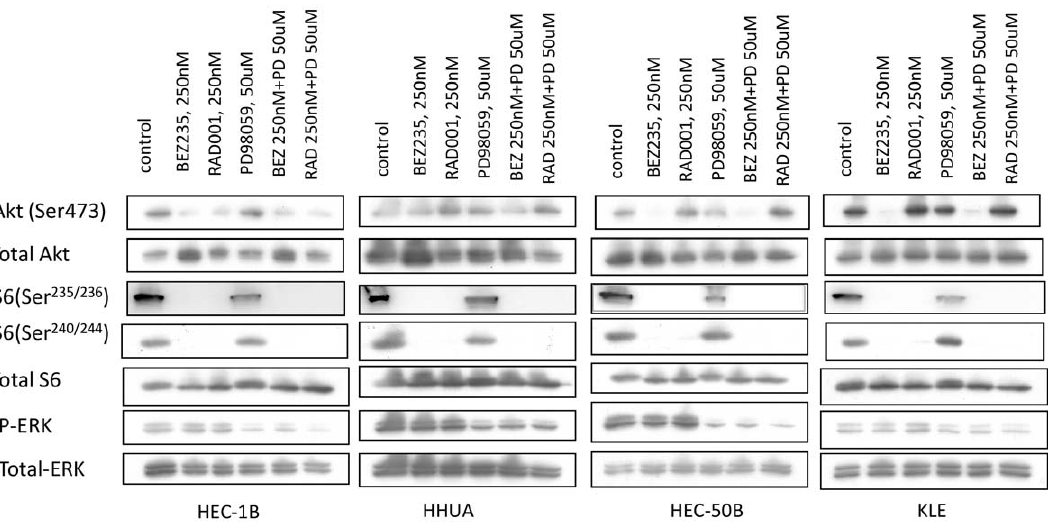
Figure 7. Inhibition of PI3K and MAPK signaling pathway by NVP-BEZ235, RAD001, and a MEK inhibitor (PD98059) in endometrial cancer cell lines with K-Ras alterations. Western blot analysis of total lysates of HEC-1B and HHUA (group C) and HEC-50B and KLE (group D) cells treated with 1 of the PI3K (or MAPK) signal inhibitors or their combination with 10% FBS. Phospho-Akt, phospho-S6, and phospho-ERK levels are shown with total Akt, total S6, and total ERK